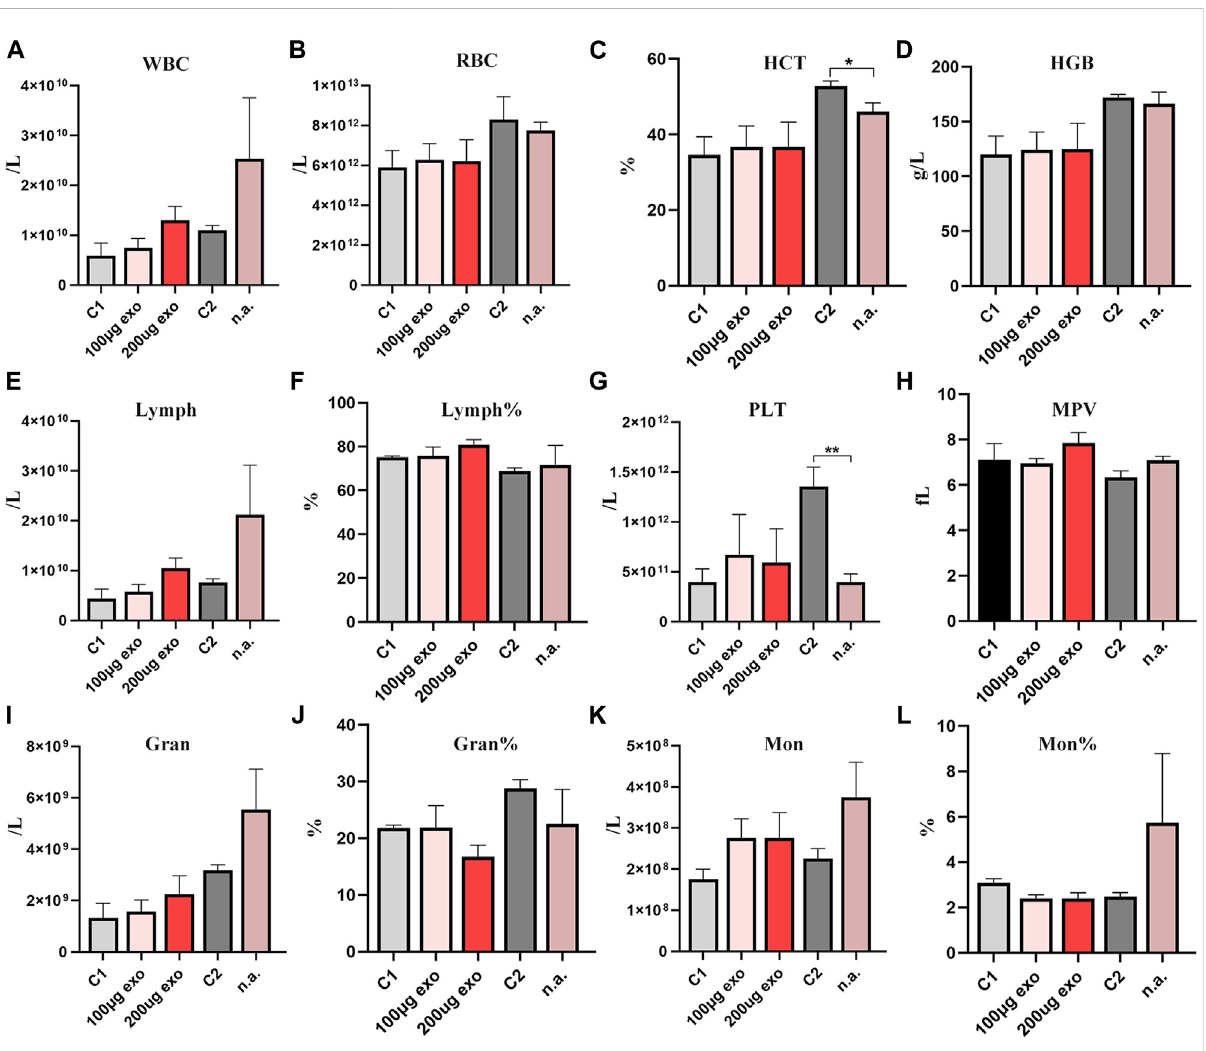
Routine blood analysesof SD rats on day 1. (A) White blood cell count. (B) Red blood cell count. (C) Hematocrit (* p < 0.05). (D) Hemoglobin. (E) Lymphocytecount. (F) %Lymphocytes. (G) Plateletcount(** p < 0.01). (H) Meanplateletvolume. (I) Neutrophilcount. (J) %Neutrophils. (K) Monocyte count. (L) %Monocytes. N =4pergroup.Dataareexpressedthemean±SEM.(C1,Control1;C2,Control2).Referenceranges:WBCs.2.9 – 15.3×10 9 / L; RBCs, 5.60 – 7.89 × 10 12 /L; HCT 36% – 46%; HGB, 120 – 150 g/L; Lymph, 2.6 – 13.5 × 10 9 /L; Lymph%, 63.7% – 90.1%; PLT, 100 – 1,610 × 10 9